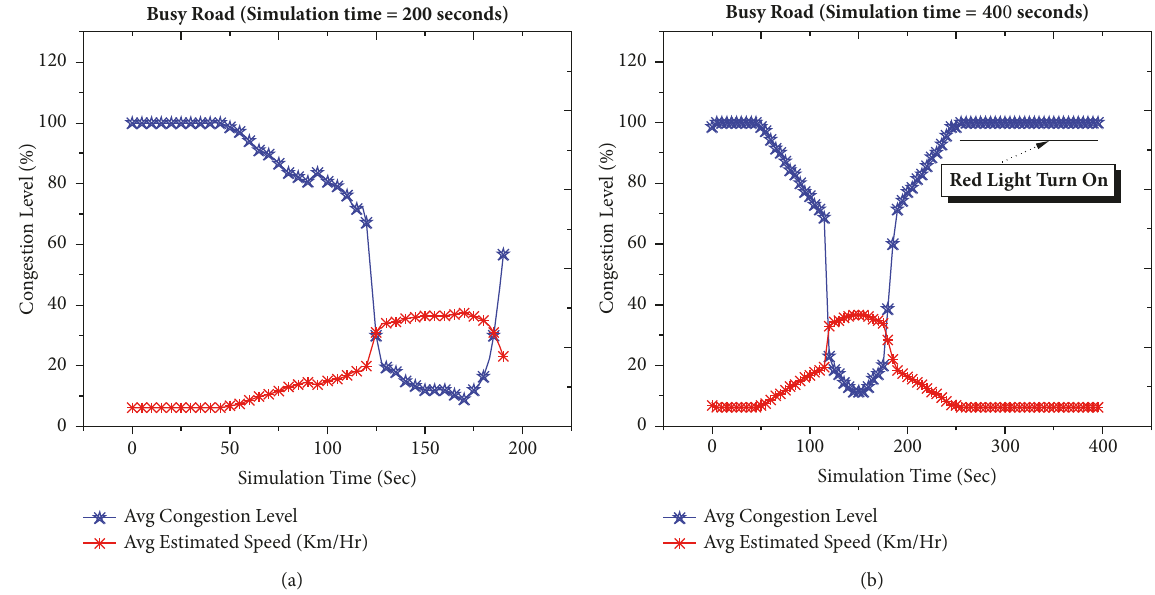
Figure 5: Temporal congestion detection and speed estimation in busy road, number of lanes = 2, DSRC Rang = 500m, car size = 5m, safety time threshold = 2 sec, maximum speed = 40Km/H, total numbers of vehicles=70, and road length=1Km.